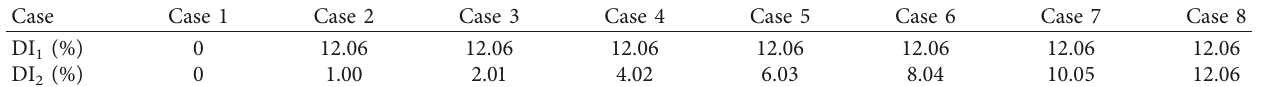
Figure 12: Curves of damage intensity and damage index in model tests (single Table 4: Damage cases in model tests (two damages).